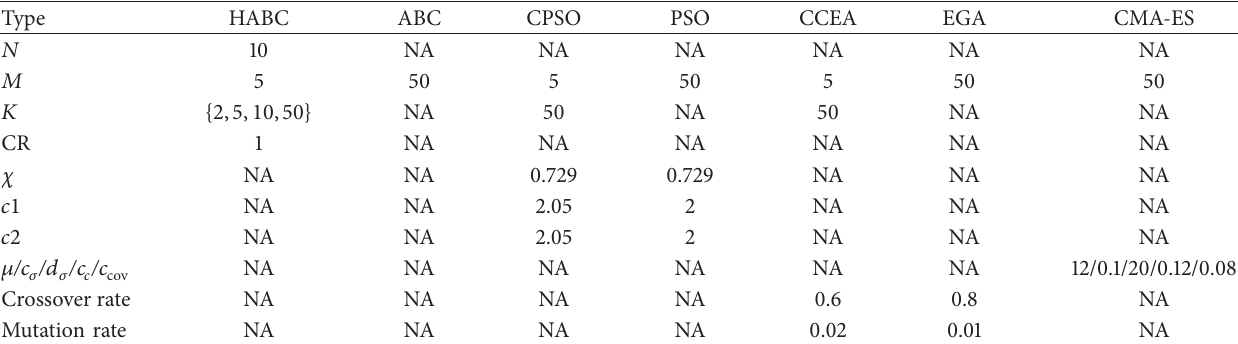
Table 1: Parameters setting for all